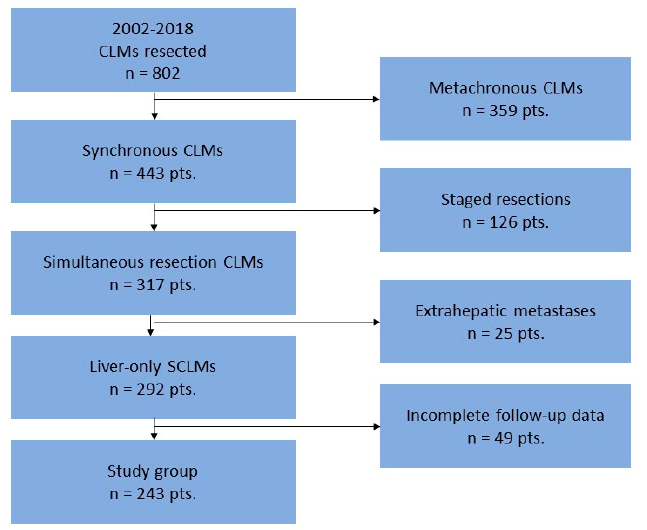
Figure 1. Flow-chart depicting the inclusion of the patients in the current